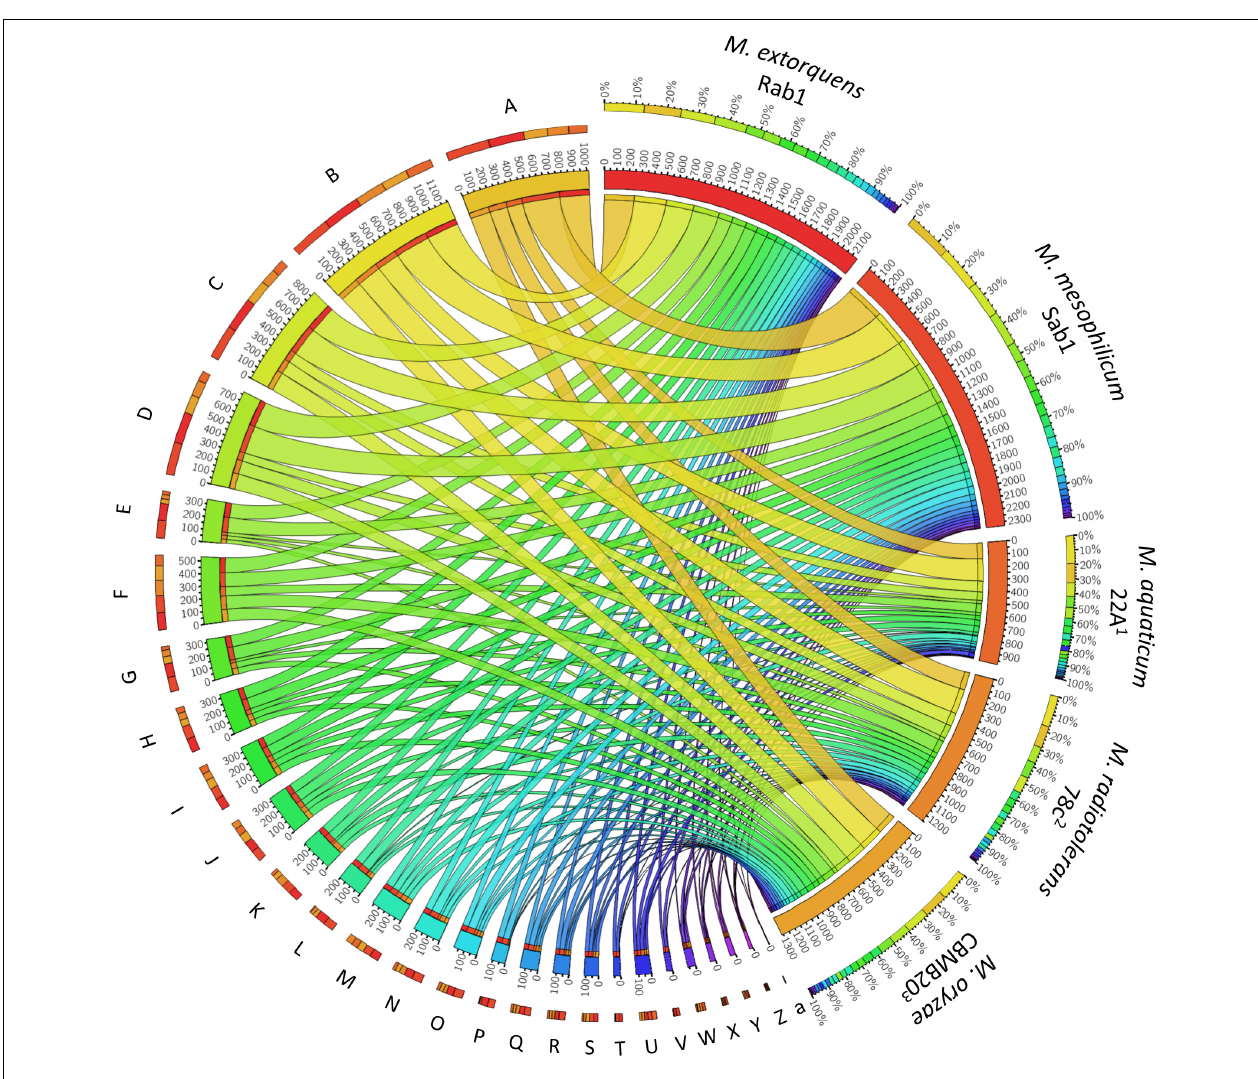
FIGURE 4 | Feature distribution within the analyzed Methylobacterium genomes and reference genomes of plant-associated methylobacteria. The two algae-growth-promoting isolates M. extorquens Rab1 and M. mesophilicum Sab1 were compared with other isolates in order to identify distinct genetic features. Detected genes were grouped according to hierarchical assignment to SEED functions and visualized with Circos (http://circos.ca) to highlight the distribution of functional categories in each genome. A detailed feature count per organism per subcategory is included in Table 2 according to the SEED database after annotation using RAST (Aziz et al., 2008). Strain references: 1 Kwak et al., 2014, 2 Tani et al., 2015, 3 Eevers et al., 2015.